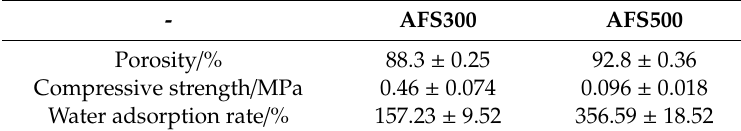
Table 1. The material properties of apatite-fiber sca ff olds (AFSs).